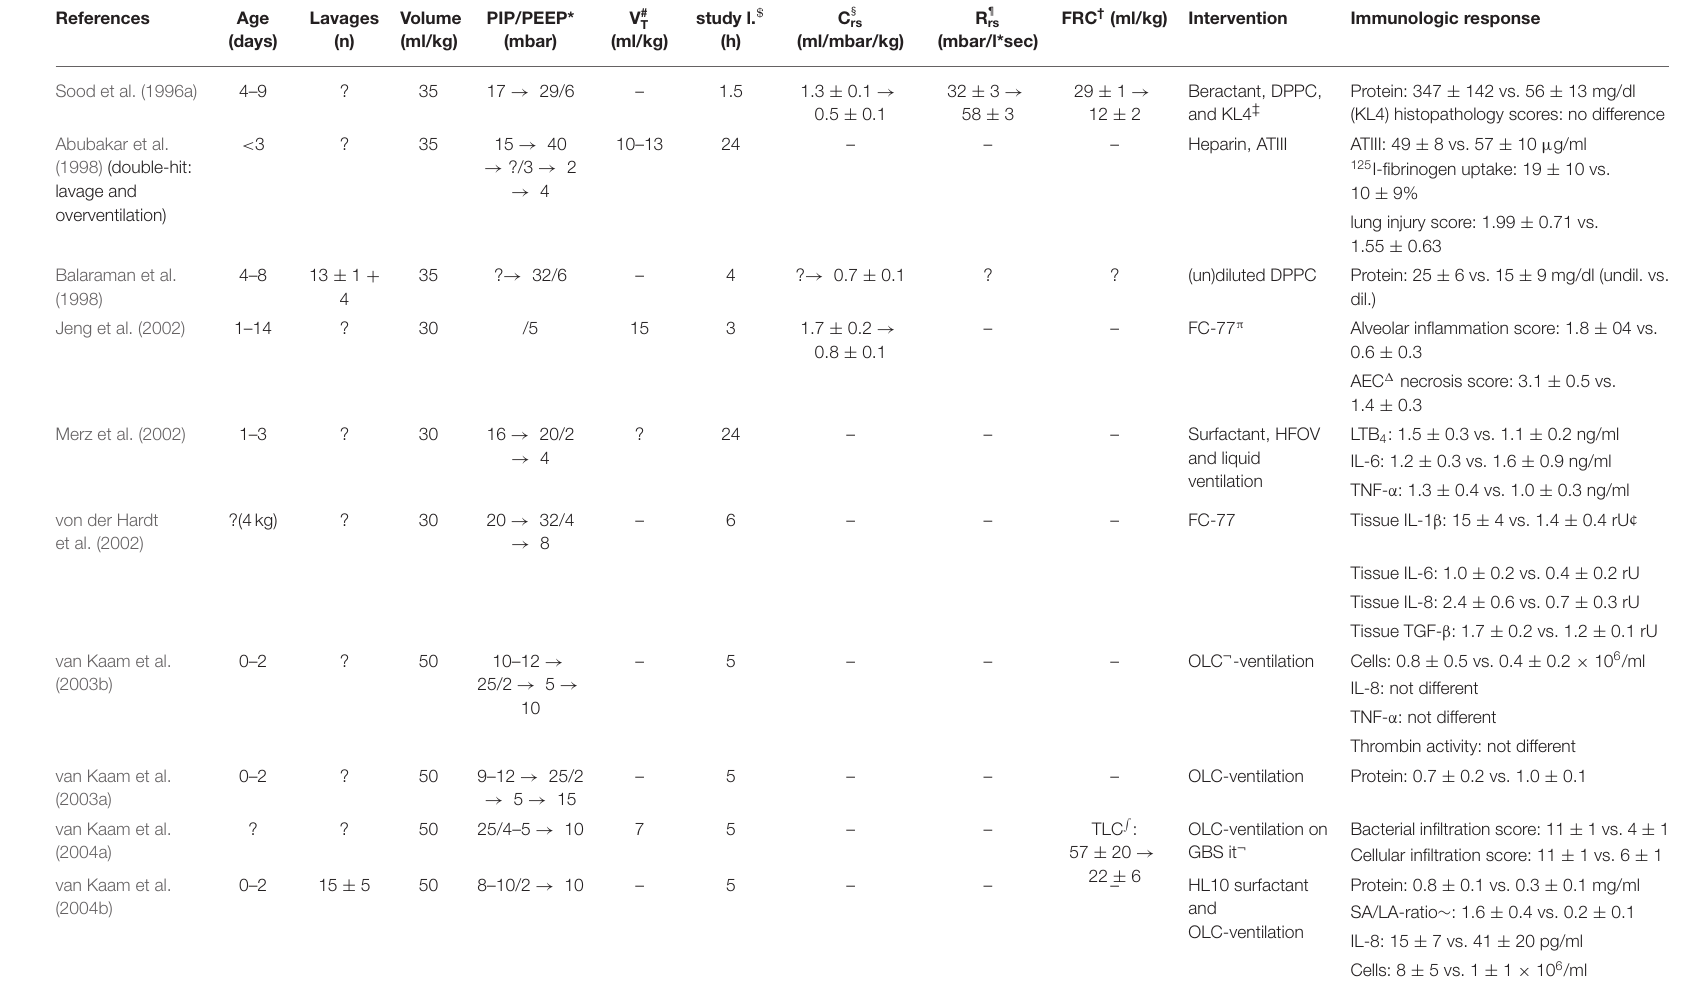
TABLE 12 | Lavage